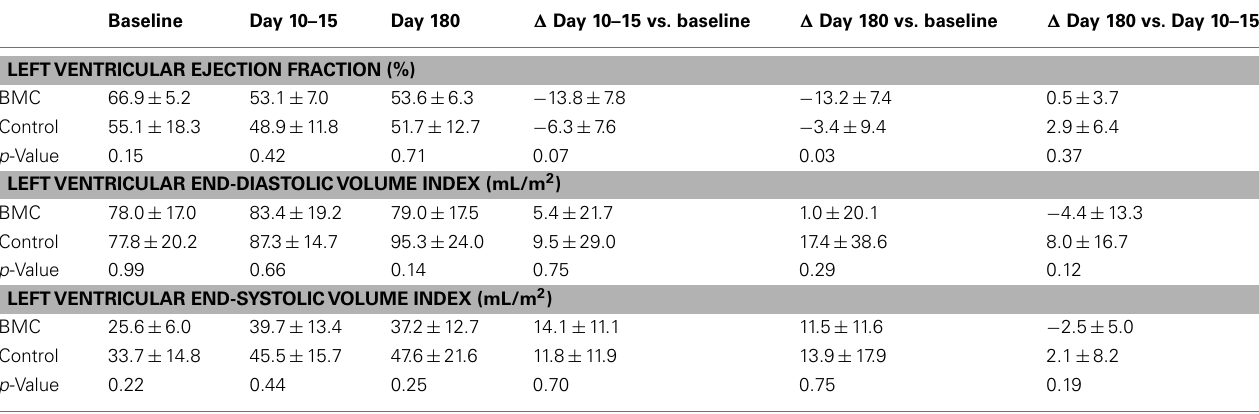
Table 3 | Effect of mononuclear stem cell therapy in left ventricular function assessed by cardiac MRI and X-ray angiography.